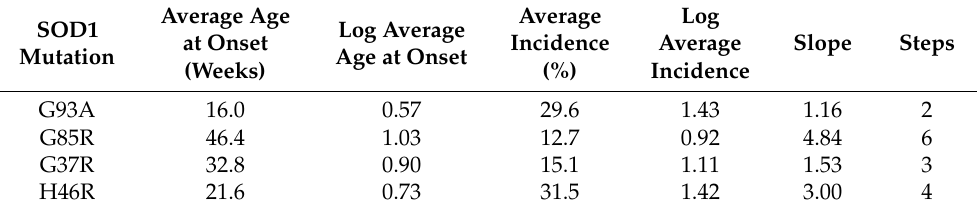
Figure 1. Linear regression and correlation of log age and log incidence in mouse populations of SOD1 G93A ( A ), SOD1 G85R ( B ), SOD1 G37R ( C ) and SOD1 H46R ( D ). The equations of the lines representing the best fit of linear regression are shown in the graphs. The slopes are highlighted in orange. Table 3. Comparison of the mouse populations overexpressing the SOD1 mutations.